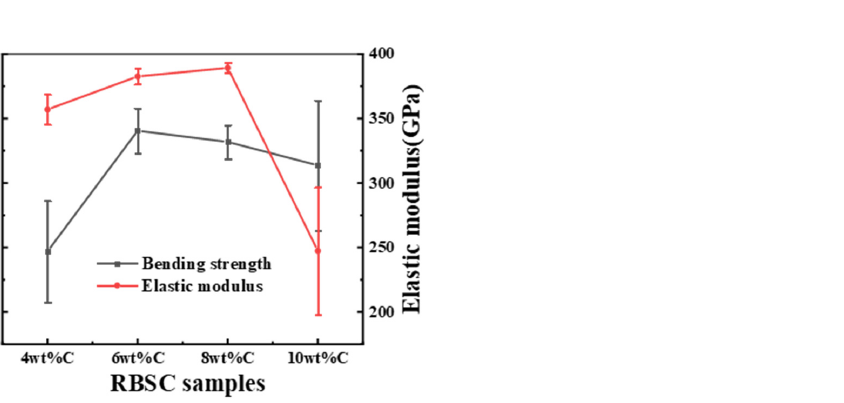
Figure 12. Bulk density and porosity of RBSCs with different carbon content. 4. Conclusions Reaction-bonded SiC with high flexural strength (340 ± 17 Mpa, 6 wt%CB) and an elastic modulus (389 ± 4 Gpa, 8 wt%CB) was successfully obtained by liquid-phase sili- conization at 1550 °C vacuum for 30 min. The design of CB distribution could reduce the content of free silicon and effectively adjust the residual stress caused by thermal stress. The fluidity of the slurry prepared by 10 wt%CB was better than 10 wt% graphite. The SiC preform which was graded by different particle sizes showed a dual pore structure of sub-